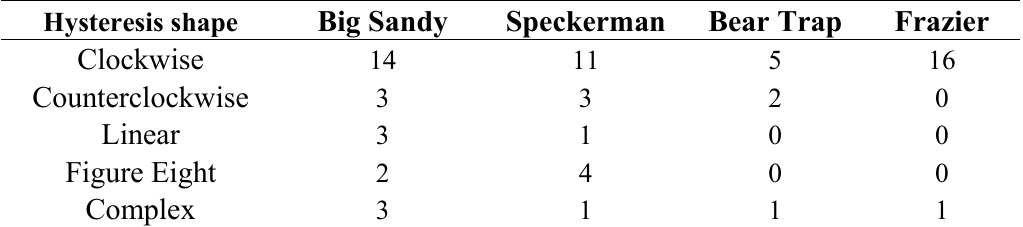
Table 6. Number of hysteresis loop patterns for turbidity events. Hysteresis shape Big Sandy Speckerman